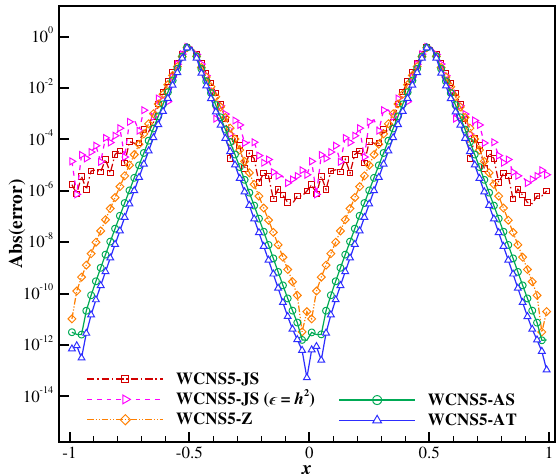
Figure 8. Computational results of a square wave.